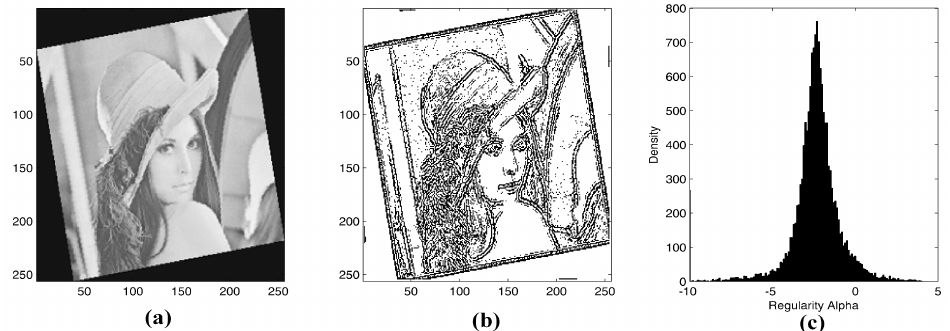
Figure 10. ( a ) Rotated Lena image (10 ◦ of rotation), ( b ) Modulus maxima lines after thresholding, ( c ) Histogram of Lipschitz Values.